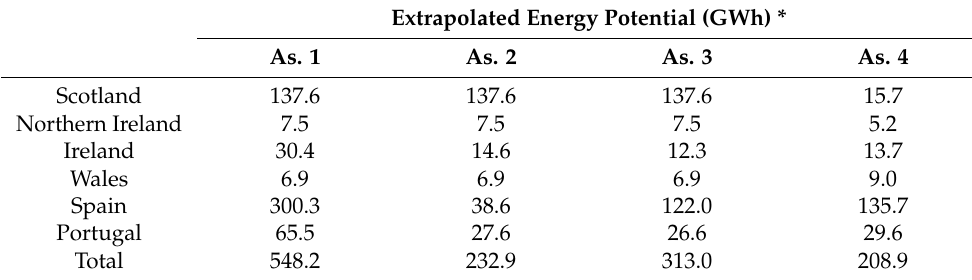
Table 3. Energy potential (GWh) for MHP extrapolated from power estimations under different assumptions (As. 1 to As. 4) for the different